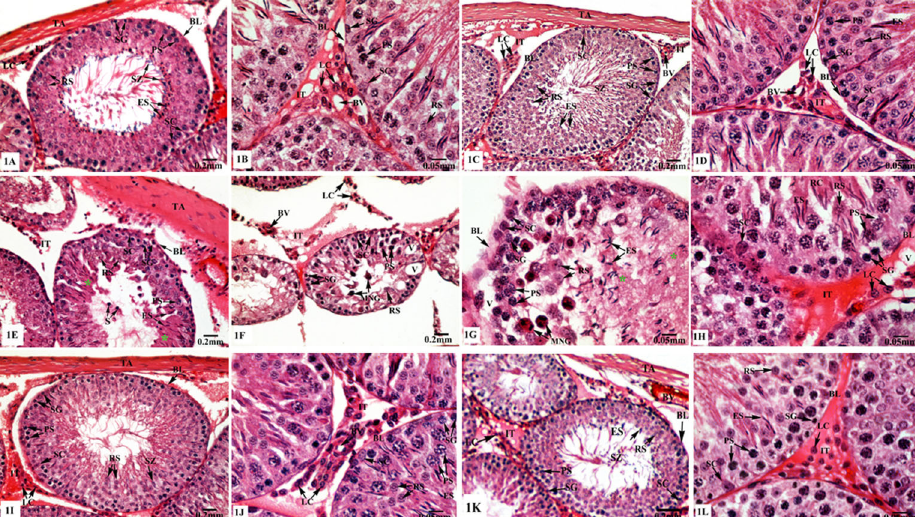
Figure 1. Photomicrographs of the testes of control and experimental animal groups stained with HE. A and B , control group with normal tunica albuginea (TA) and seminiferous tubules having basal laminae (BL), Sertoli cells (SC), spermatogonia (SG), primary spermatocytes (PS), rounded (RS) and elongated (ES) spermatids and spermatozoa (SZ), as well as interstitial tissues (IT) with Leydig cells (LC). C and D , sham group with intact testicular architecture. E – H , taxol (TXL)-treated rats with thickened tunica albuginea (TA) surrounding deteriorated tubules having ruptured basal laminae (BL), distorted SC, and apoptotic germinal cells; SG, PS, RS, and ES with residual cytoplasmic remnants (green asterisks), as well as vacuolation (V), sloughed germ cells (S), and multinucleated giant cells (MNG). Also, destructed interstitial tissues (IT) with pyknotic LC and congested blood vessels (BV) are displayed. I and J , melatonin (MLT)-treated rats with normal TA enclosing tubules having regular SC, SG, PS, RS, and ES, besides the IT with LC. K and L , regular testicular architecture of TA, seminiferous tubules with germinal epithelia and IT in MLT + TXL-treated rats. A, C, E, F, I, K: scale bar 0.2 mm. B, D, G, H, J, L: scale bar 0.05 mm.